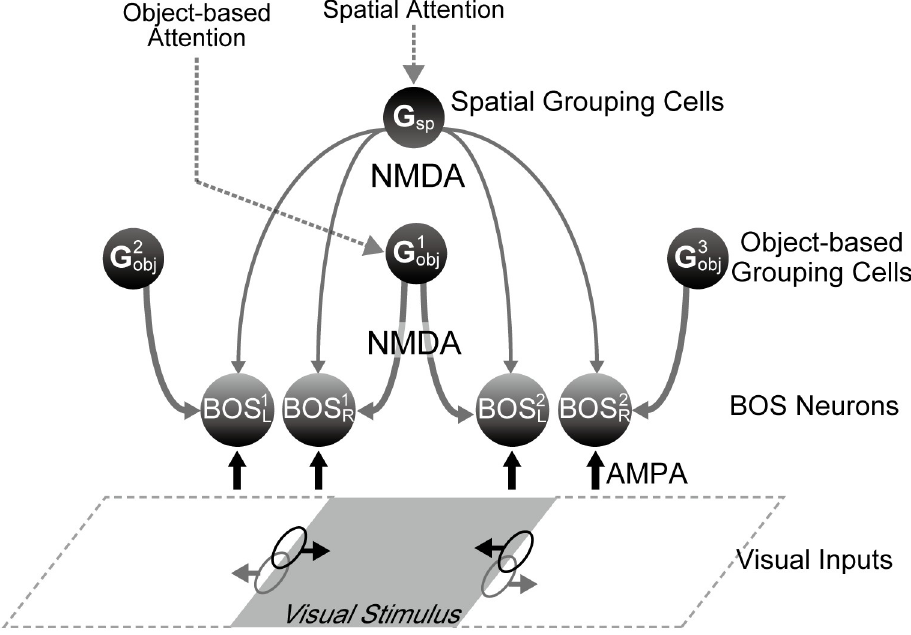
Fig 2. Model architecture. Two different types of G -cells (balls with “G”) are part of the model: spatial grouping cells ( G ) and object-based grouping cells ( G ). Whereas G -cells implement spatial attention, i.e . attention to everything sp obj sp within a circumscribed spatially defined area, G obj -cells impart grouping structure of objects in the scene and mediate object-based attention. The latter are similar to the grouping cells from refs [25, 26, 41]. Feedback signals from these G - cells modulate activity of BOS neurons (balls with “BOS”) by NMDA-type connections (gray downward pointing arrows). Black and gray ellipses represent the locations of RFs of BOS neurons which are driven by visual input through AMPA-type synapses (black upwards pointing arrows). Black and gray horizontal arrows from RFs point toward the preferred side of the corresponding BOS neuron. For description of subscripts and superscripts of BOS cells see